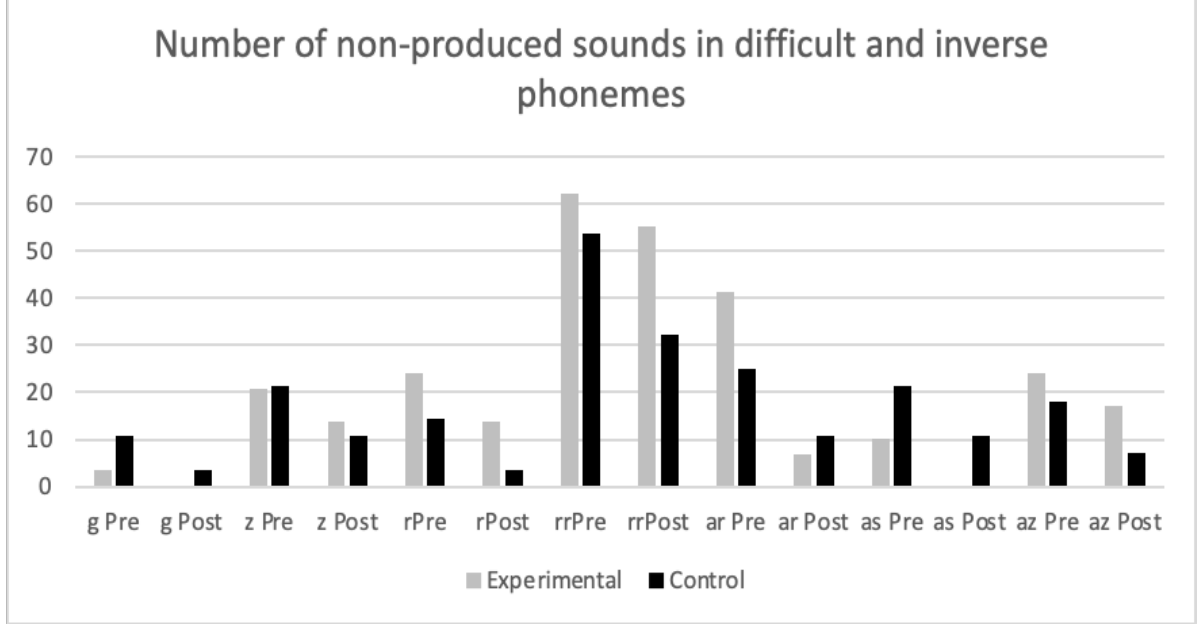
Figure 2. Number of non-produced sounds in difficult and inverse phonemes in the pretest and post-test in experimental and control groups.